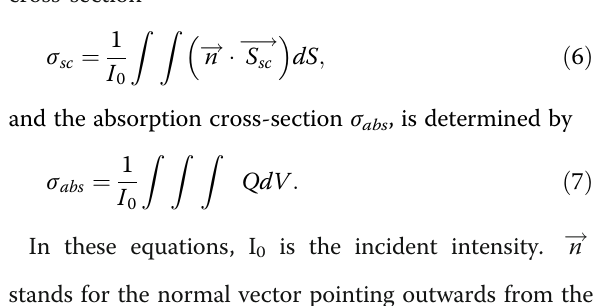
(cid:6) ! indicates the Poynting vector plasmonic nanocluster, S SC for the scattered field. The integral in Equation (6) is taken over the closed surface of the scatter. Q is the power loss density in the oligomer. The integral in equa- tion (7) is taken over its volume. The extinction spectra are calculated in the selected wavelength range of mid-infrared. The Perfectly Matched Layer (PML) is ap- plied around the proposed nanostructure to avoid the reflected light fields. The thickness of the graphene is meshed at least five layers to guarantee simulation accuracy.